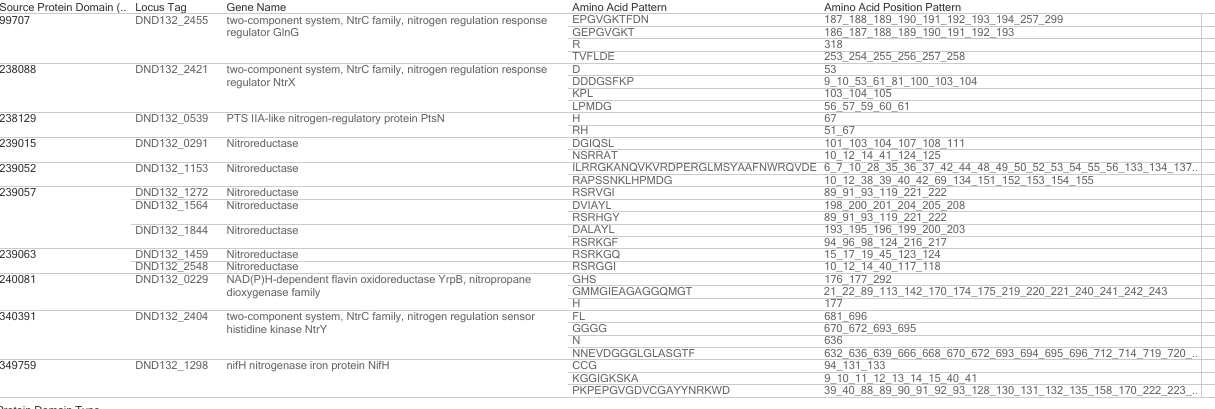
Figure A1. Evidence that the process for analytics of functional sites of protein sequences can be applied beyond the universal stress proteins. The visual representation integrates the protein domain identifier (source protein domain (PSSM- ID)), locus tag, gene name, amino acid pattern and amino acid position pattern. The protein sequences for Desulfovibrio desulfuricans ND132 were obtained from the Integrated Microbial Genomes and Microbiomes (IMG/M) system. The protein sequences with annotation for nitrogen metabolism are relevant to our research on the denitrification by microbial communities in oysters [64] .